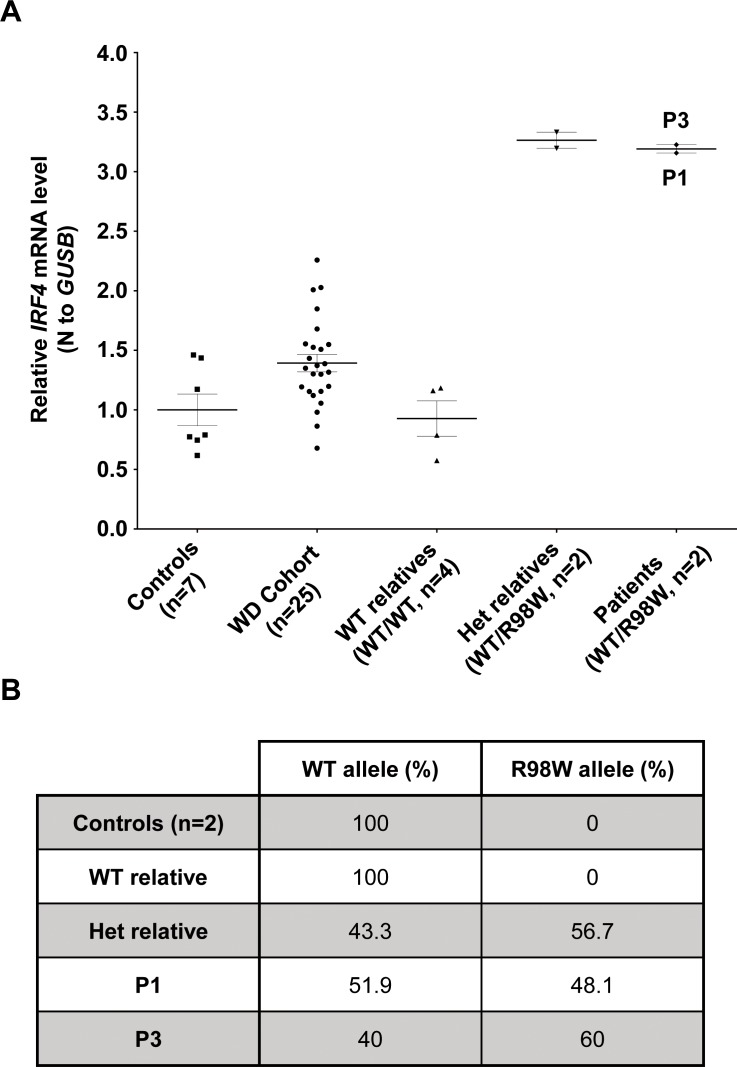
IRF4 mRNA levels in EBV-B cells. (A) Total RNA extracted from healthy unrelated controls (n = 7; IRF4 WT/WT), patients diagnosed with Whipple’s disease (n = 25; WT/WT for all coding exons of IRF4) not related to this kindred, healthy homozygous WT relatives (n = 4, IRF4 WT/WT), patients with monoallelic IRF4 mutations (n = 2; IRF4 WT/R98W) and asymptomatic heterozygous relatives with monoallelic IRF4 mutations (n = 2; IRF4 WT/R98W) was subjected to RT-qPCR for total IRF4. Data are displayed as 2-ΔΔCt after normalization according to endogenous GUSB control gene expression (ΔCt) and the mean of controls (ΔΔCt). The results shown are the mean ± SD of three independent experiments. (B) Calculated frequency (%) of each mRNA (WT and R98W allele) obtained by the TA-cloning of cDNA generated from EBV-B cells from healthy unrelated controls (n = 2), healthy homozygous WT relatives (n = 1), patients with monoallelic IRF4 mutations (n = 2) and asymptomatic heterozygous relatives with monoallelic IRF4 mutations (n = 1).